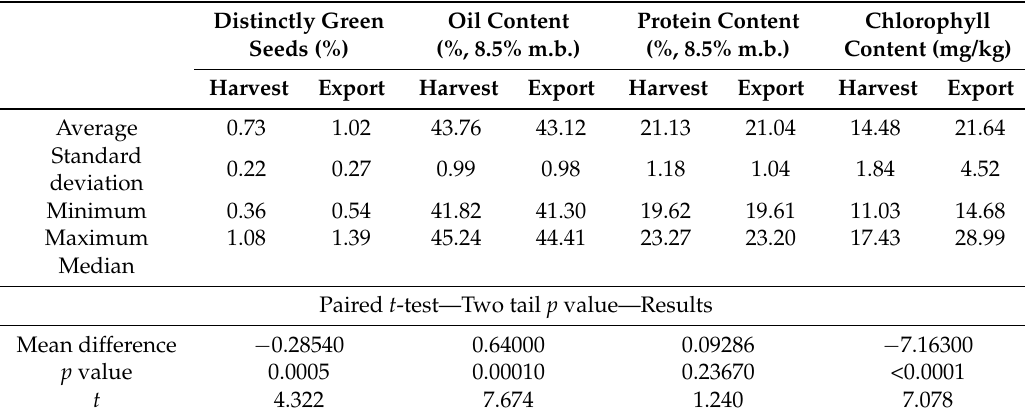
Table 3. Yearly mean average and standard deviation for harvest (HSD) and exports (ECD) samples of Canada No. 1, Canola for green seed count, oil, protein and chlorophyll content. Distinctly Green